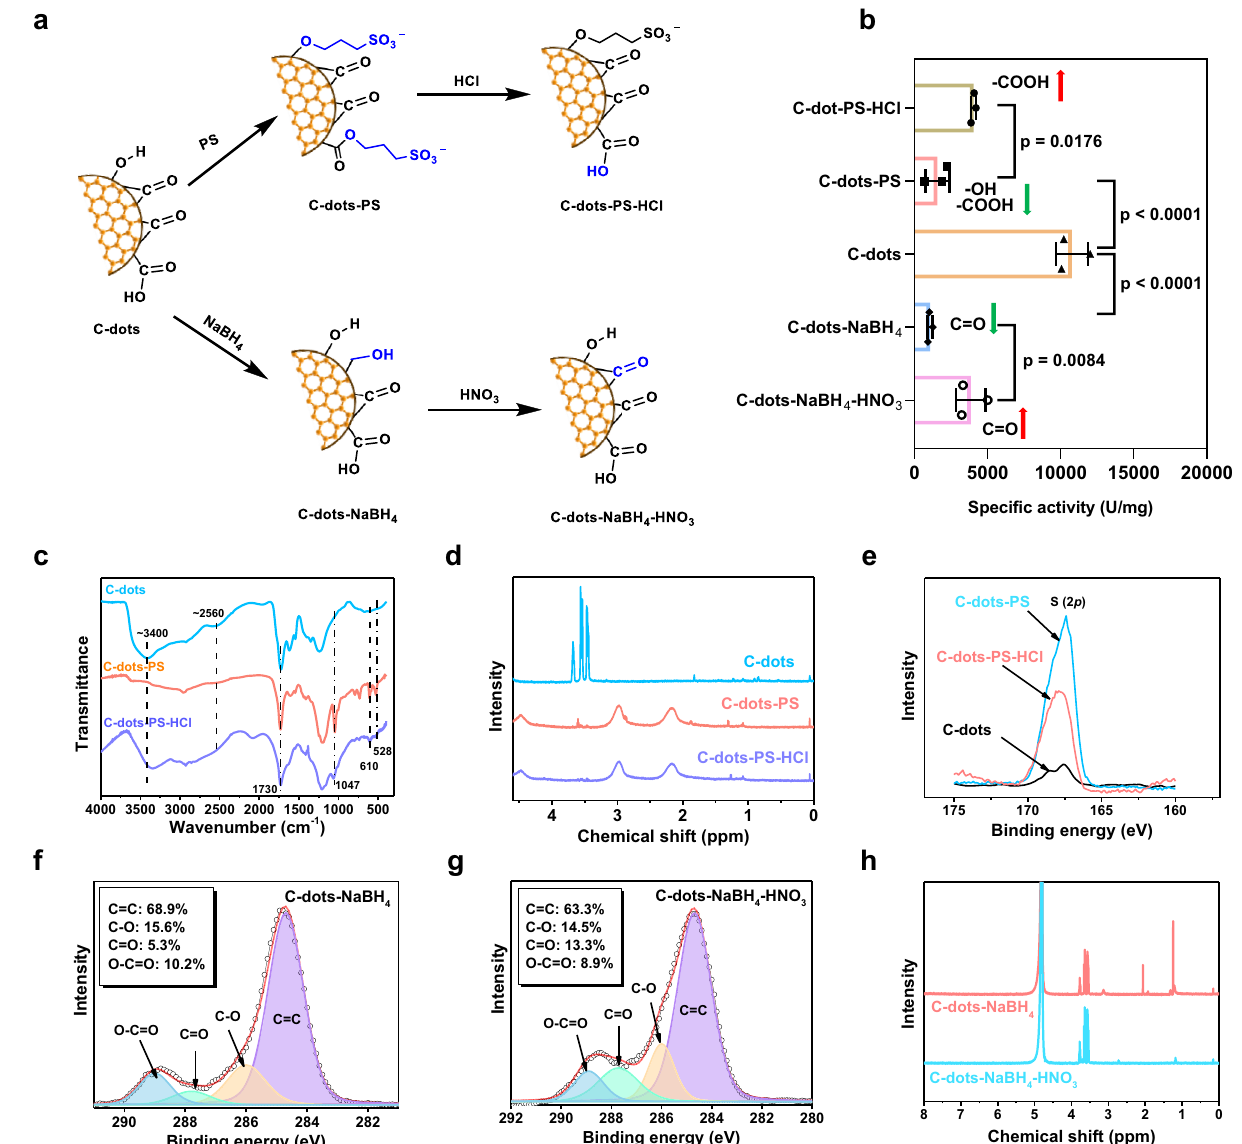
Fig.2|Surfacemodi fi cationstodeterminethecatalyticactivesiteofC-dotSOD nanozymes. a Illustration of C-dots modi fi cation. b SOD-like activity change of C-dots before and after passivation, reduction, and re-oxidation. c FT-IR, ( d ) 1 H NMR, and ( e ) S 2 p XPS spectra of C-dots, C-dots-PS and C-dots-PS-HCl. C 1 s high- resolution XPS spectra with identi fi cation of peaks by curve fi tting of ( f ) C-dots-